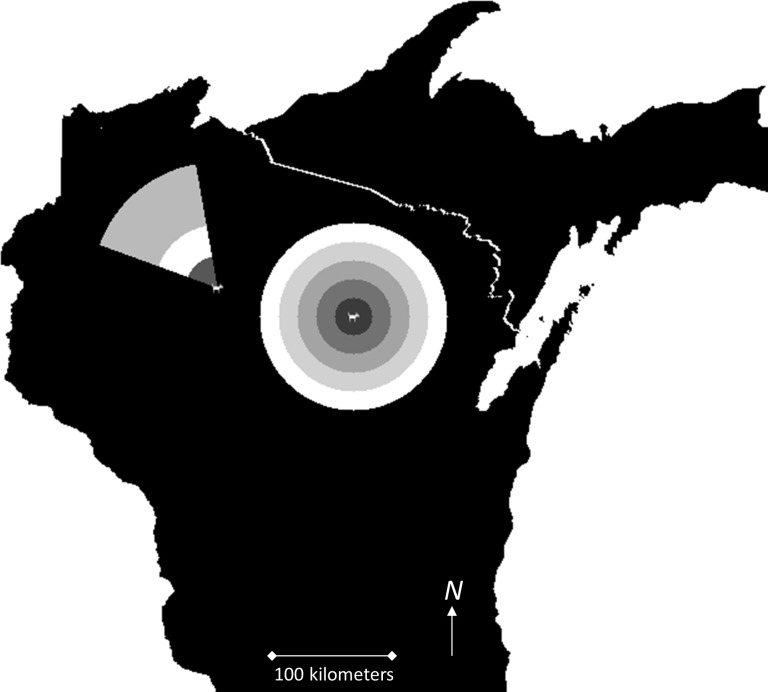
Simulations for an individual-based spatially explicit model for southern Lake Superior wolves.We varied perception neighborhoods where simulated wolves could search for mates 1, 2, 3, 4 and 5 territories away (concentric circles) and the log mean parameter in the lognormal distribution used to calculate individual dispersal distance with average dispersal distances of 25, 50, and 100 kilometers (sectors) on a simulated landscape.